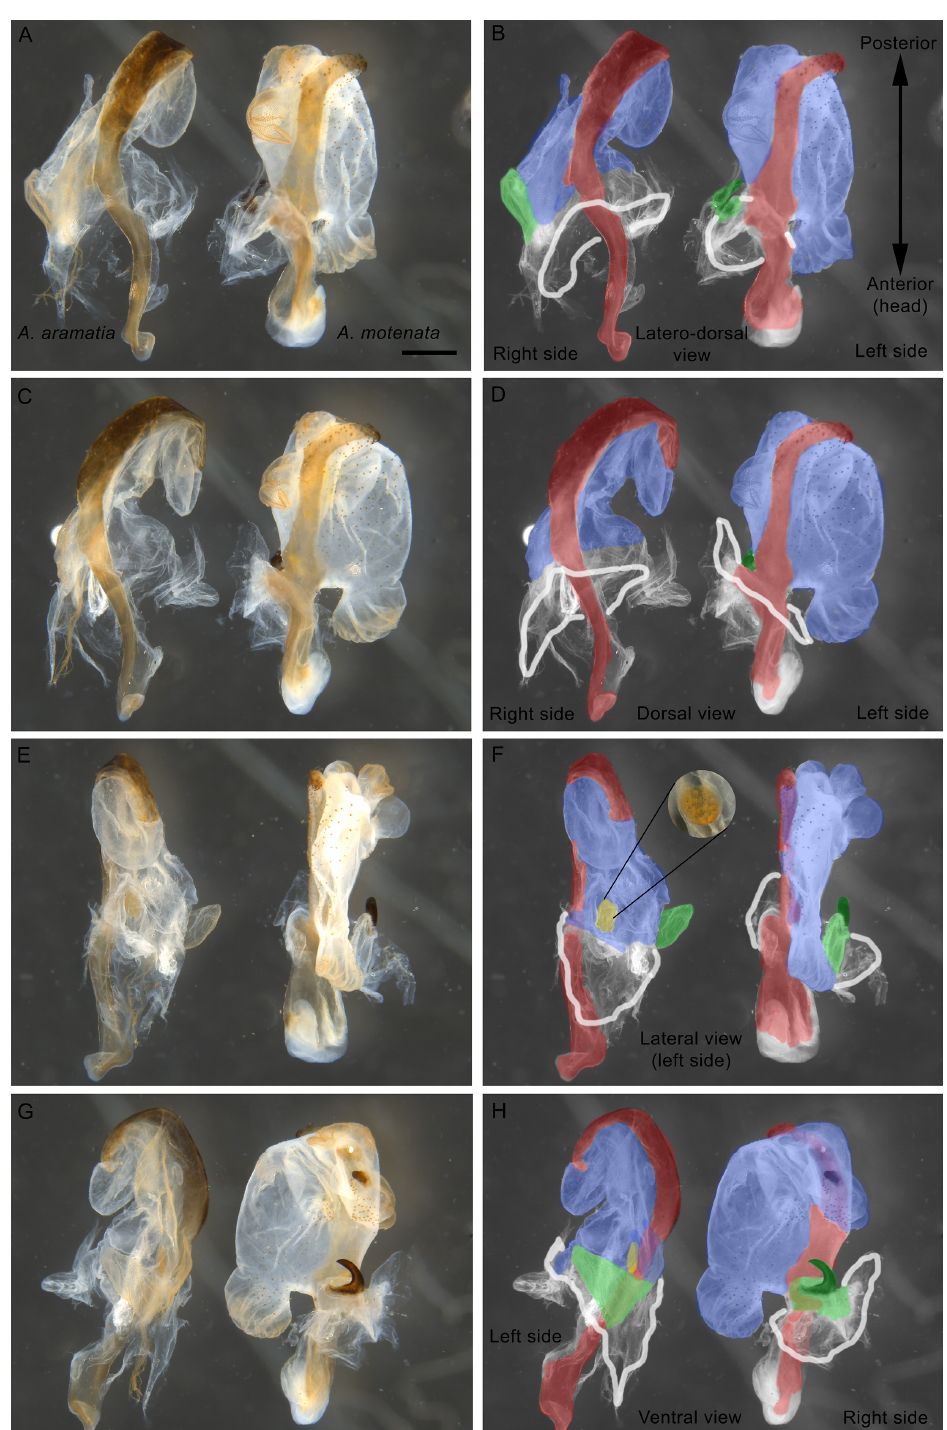
Fig. 43. Male genitalia of Arumatia aramatia Ghirotto gen. et sp. nov. and Arumatia motenata Ghirotto gen. et sp. nov., treated with KOH. A, C, E, G . Treated genitalia of A. arumatia (left side) and A. motenata (right side) in different views. B, D, F, H . Same pictures as respective preceding, structures coloured for visualisation: red = dorsal sclerite; blue = longitudinal lobe; green = basal lobe; yellow = internal sclerotization; white line = area of attachment to the body; inset (F) = detail of internal sclerotization, internal view. All pictures to the same scale. Scale bar: 0.5 66